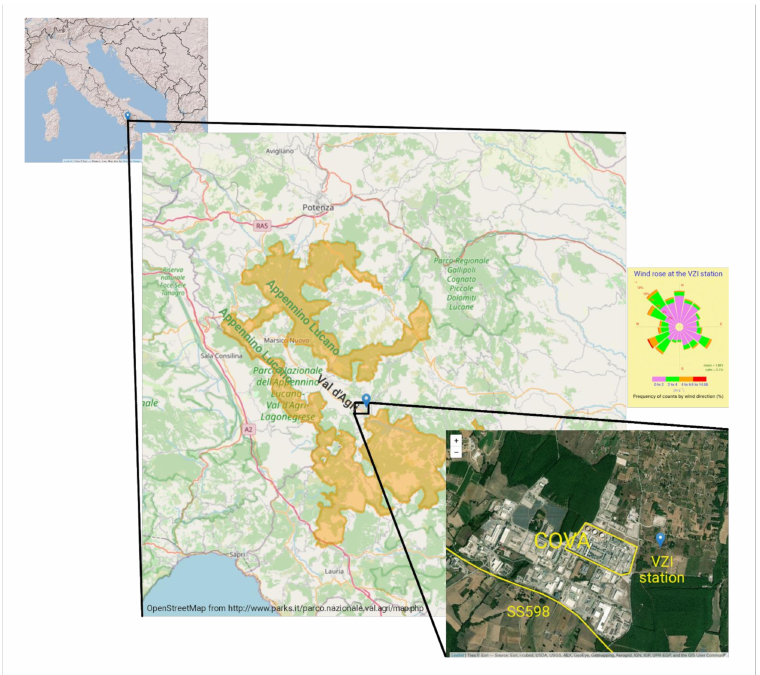
Figure 1. Map of the study area and wind rose based on the hourly data at the VZI station over the study period